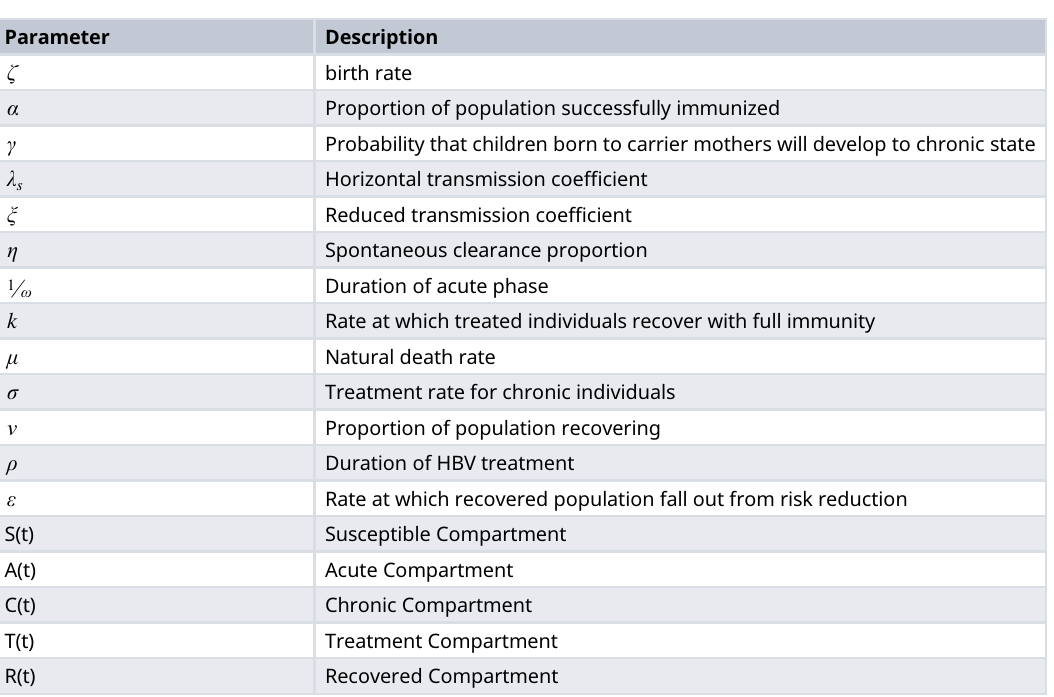
Table 1. Parameter